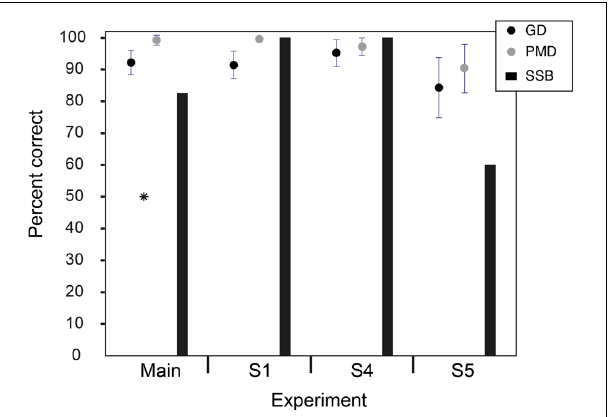
FIGURE 2 | Results of the main experiment and supplementary experiments. Mean scores (percent correct) are shown for the gender discrimination (GD) and production mode discrimination (PMD) main experiment (no masker) and supplementary experiments S1 (with masker), S4 (decreased level), and S5 (speech levels). Scores were all well above chance (*). (Error bars are ± 1 SD).The percentages of listeners to correctly identify the SSB are also